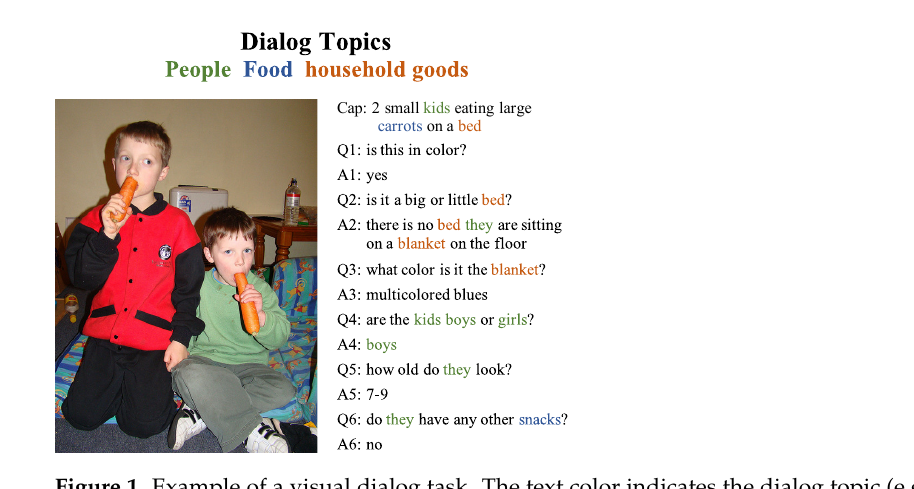
Figure 1. Example of a visual dialog task. The text color indicates the dialog topic (e.g., “people”, “food”, and “household